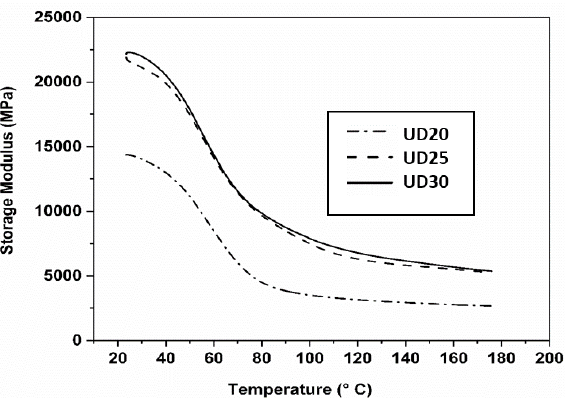
Figure 8. Storage modulus curves of DMA-tested UD composite specimens at a temperature range from 20 °C to 180 °C.